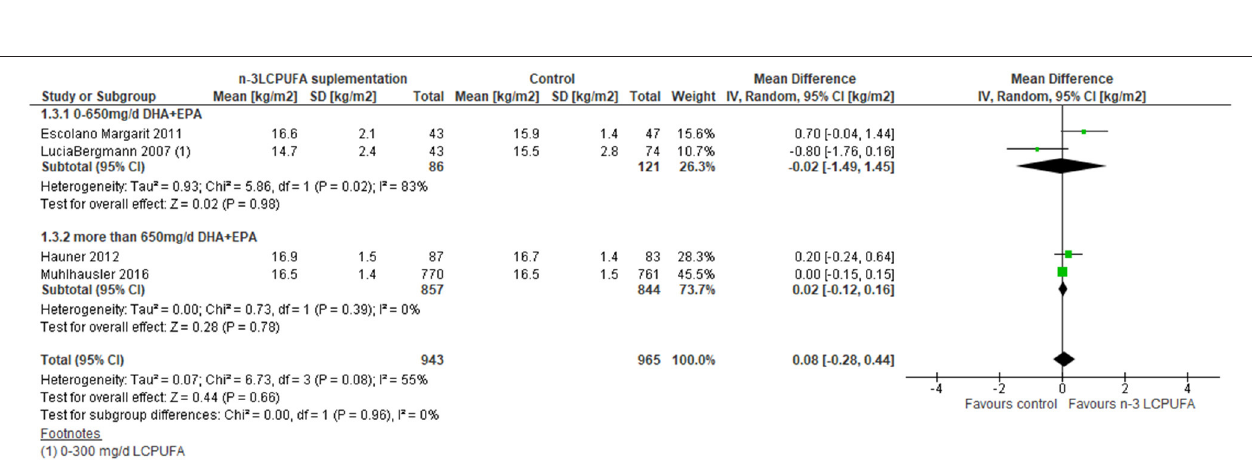
FIGURE 4 | Maternal n-3 LCPUFA supplementation in pregnancy, dose given and offspring BMI at 0–4 years of